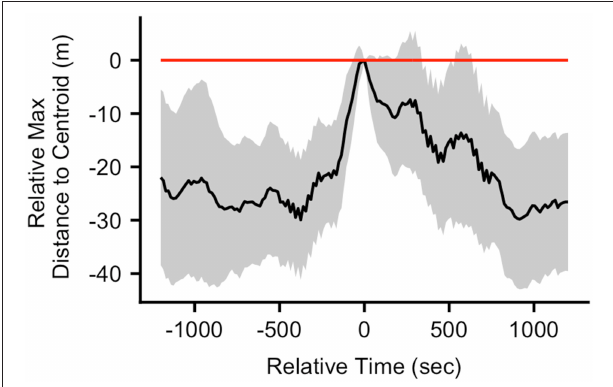
FIGURE 3 | The mean difference (with 95% confidence interval) in the maximum distance to centroid at each time point in the ± 20min interval relative to the maximum distance to centroid at the time of the call ( n = 38 calls). Relative time = 0 indicates the time of the calls.